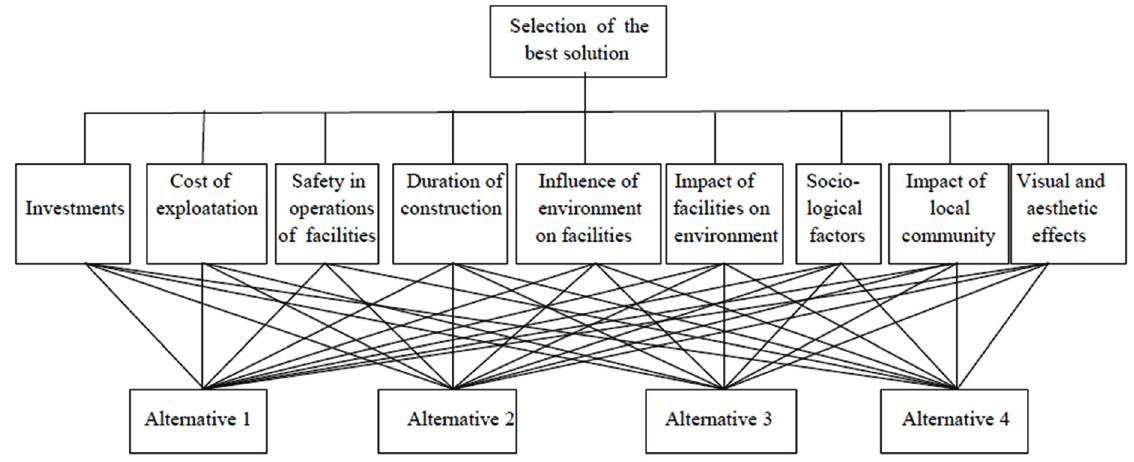
Fig. 3. Hierarchy structure of the case